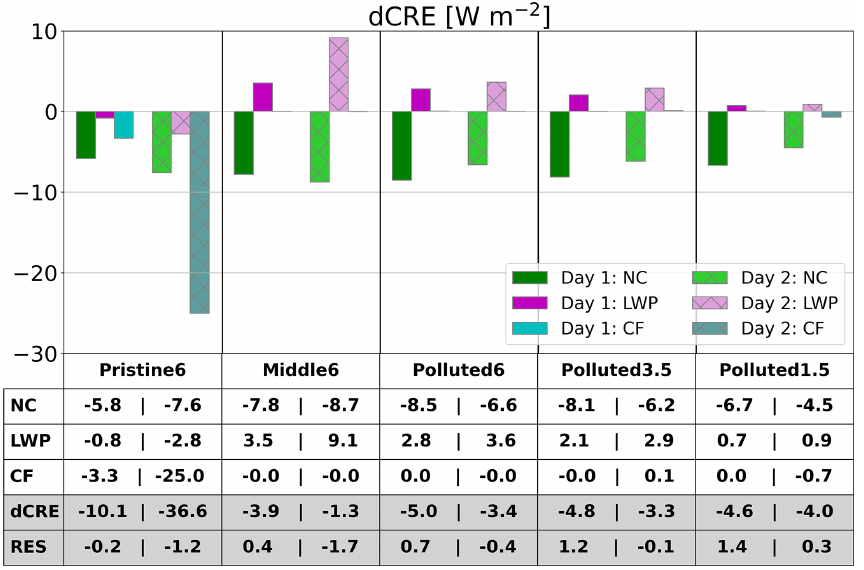
Figure 10. The difference in the decomposed 24h cloud radiative effect between the Plume and Ctrl runs (dCRE) for each case, showing contributions from dCRE N (green), dCRE LWP (magenta), and dCRE CF (blue). The darker colors show the average dCRE for Day 1, and c the lighter colors with hatching show the averages for Day 2. The table below the histograms shows dCRE N and the residual between the actual dCRE and that estimated using an approach shown in Appendix B for Day 1 (left bars) and Day 2 (right bars).